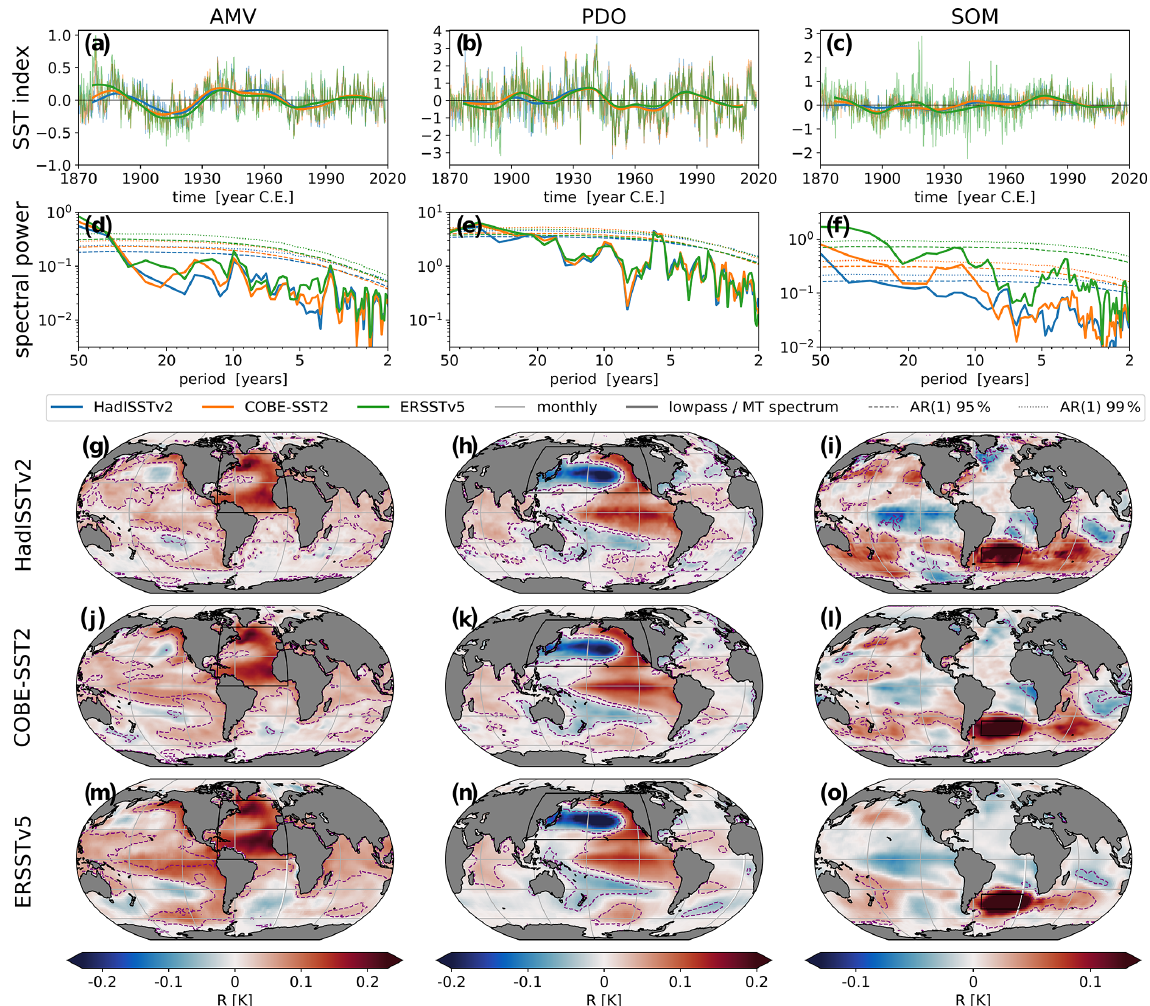
Figure 9. Comparing results from three SST products: HadISSTv2 (as in main text), COBE-SST2, and ERSSTv5. Panels (a–c) show the SST indices like Fig. 2, (d–f) the spectra like Fig. 4, and (g–o) regression patterns like Fig. 3. The time series plots show both the monthly (thin) and 13-year low-pass-filtered (thick) de-seasonalized and two-factor detrended time series. For each of the multi-taper spectral estimates, 10000 AR(1) processes have been simulated to provide a 95% (dashed) and 99% (dotted) significance estimate. The regression maps show the correlation coefficient of the monthly de-seasonalized and detrended SST data with indices. The index areas are marked by black rectangles, and areas of 98% correlation significance are enclosed by purple dashed